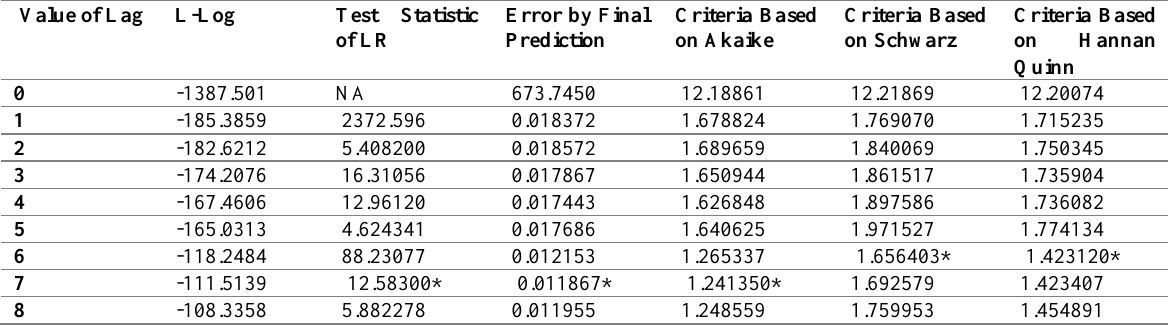
Table 6 and 7explain the optimal lag of the underlying variables in VAR is 8. The LaGrange criteria, Error by Final Prediction, Criteria Based on Akaike, Criteria Based on Schwarz and Criteria Based on Hannan Quinn indicate that the model chooses 8 period lags for their optimal calculation for public and private sector banks. Table 8: Result of Optimal Lag Selection of Small Finance Banks